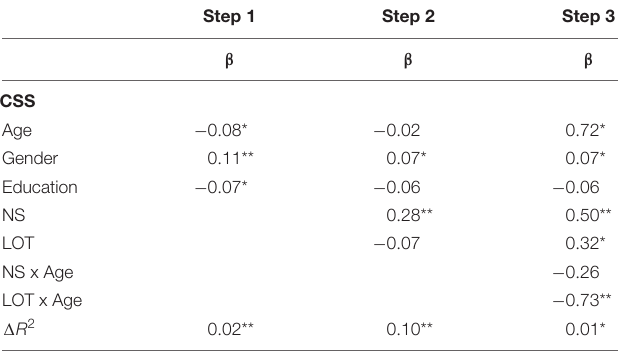
TABLE 2 | Hierarchical regression model for cyberchondria (CYB).